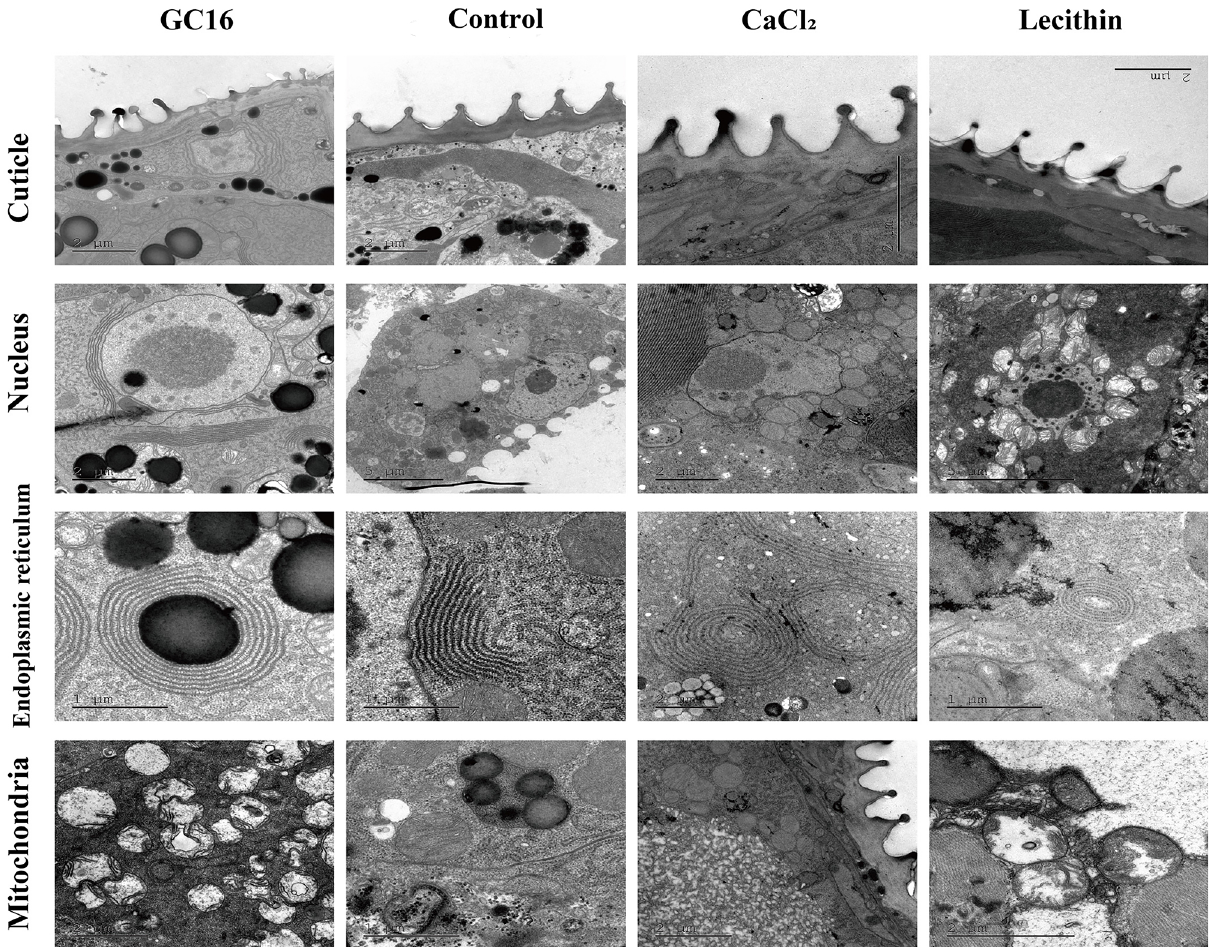
Figure 6. Transmission electron microscopy (TEM) observation of T. pueraricola after treated with GC16, Control (water), CaCl 2 , and lecithin for 24 h. The cuticle, nucleus, endoplasmic reticulum, and mitochondria of mites were